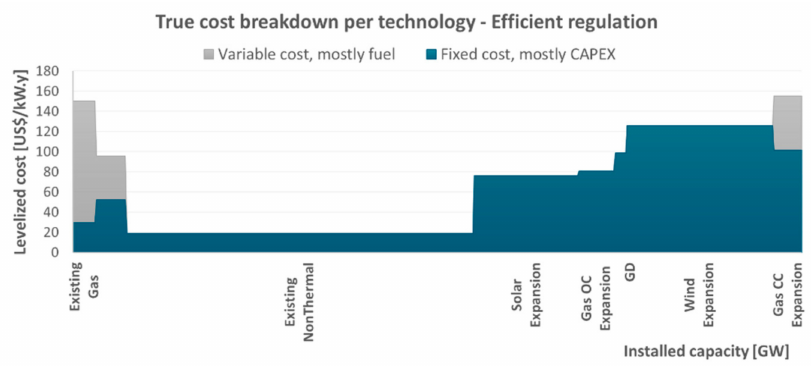
Figure 14. Cost breakdown in the efficient regulation scenario. Total cost (variable + fixed) equal to USD 20.8 billion.